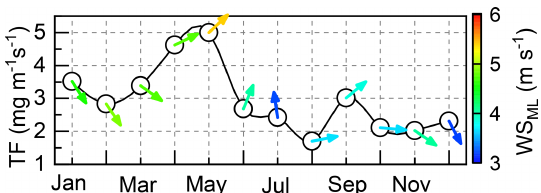
Figure 4. Seasonal variations in the mixing layer TF of PM 2 . 5 and the transport